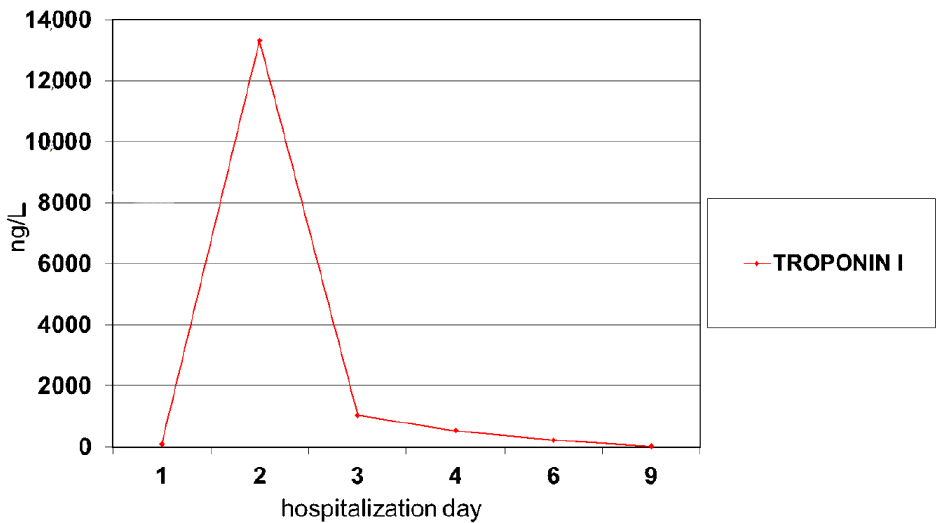
Figure 1. Troponin I values during myocarditis treatment.